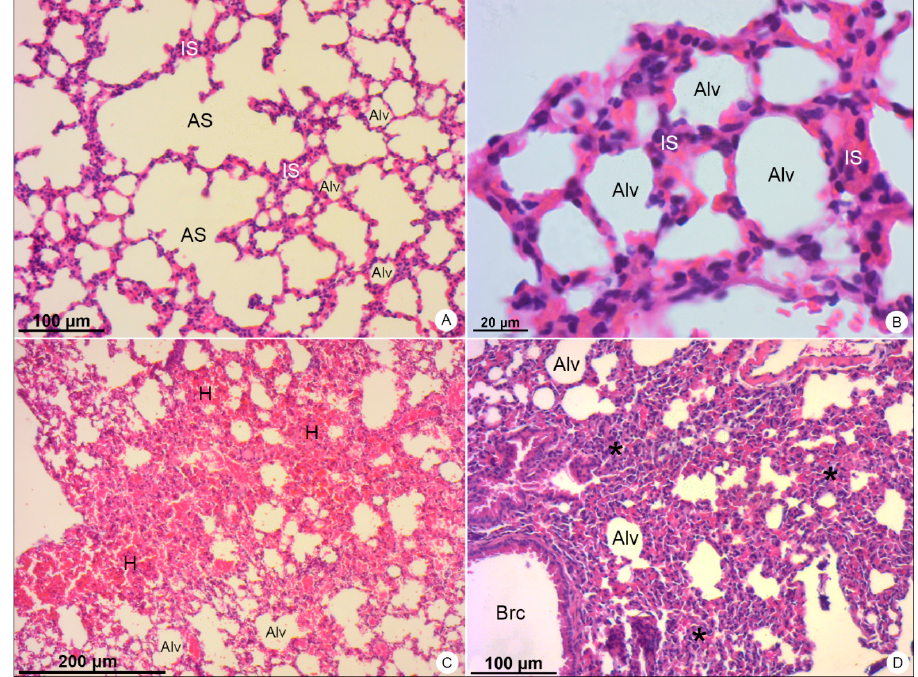
Figure 4. Lung samples of BALB/c mice stained with hematoxylin and eosin and observed in bright field microscope. ( A , B ) Negative control samples. Alveolar sac (AS); alveolus (Alv); interalveolar septum (IS). ( C , D ) DENV-4-infected samples. Areas of hemorrhage (H); thickening of the interalveolar septa (*); bronchiole (Brc). Magnification: ( A ) = 100×; ( B ) = 400×, ( C ) = 50×; ( D ) = 100×. Viruses 2021 , 13 , x FOR PEER REVIEW The transmission electron microscope analysis revealed the presence of mononuclear (Figure 5B–D) and polymorphonuclear (Figure 5B,D) inflammatory cells inside the capil- lary, as well as platelets and erythrocytes within the alveolar space (Figure 5D).